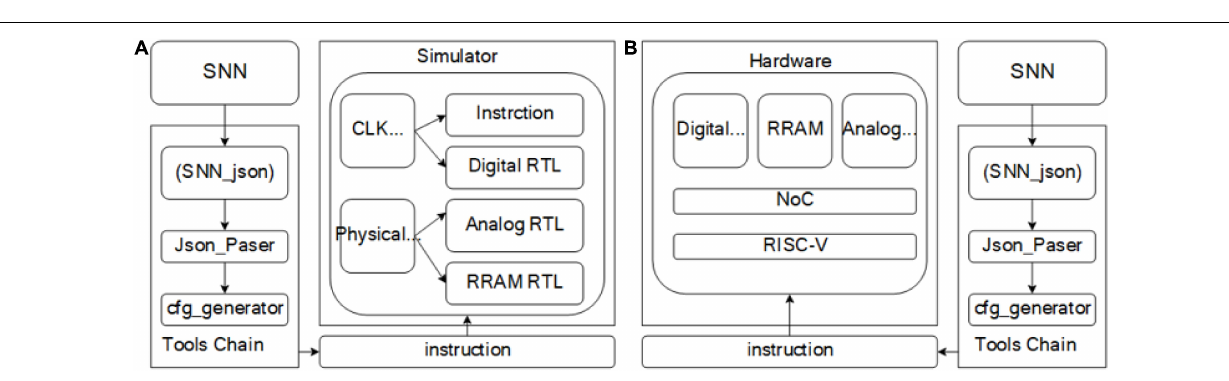
FIGURE 3 | (A) Software system. (B) Hardware system. The software system and hardware system share a set of tool chain, which is composed of SNN_JSON, JSON interpreter and instruction generator. After the tool chain generates a machine code, it is transmitted to the system through the instruction delivery